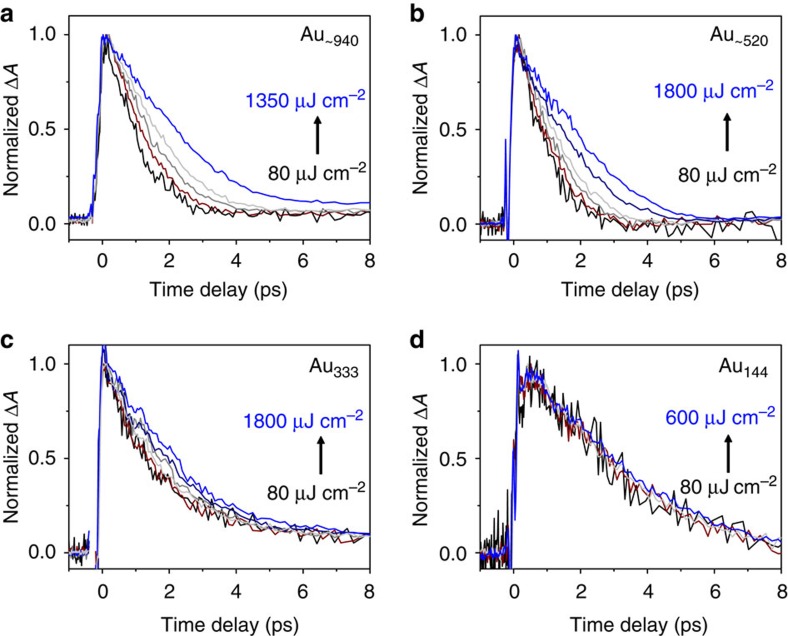
Pump power-dependent electron dynamics of gold nanoparticles.Normalized decay kinetics as a function of pump fluence for (a) Au∼940, (b) Au∼520, (c) Au333 and (d) Au144; the kinetics at the maximum of SPR peak of each gold nanoparticle was monitored; for Au144, GSB ∼460 nm was monitored.